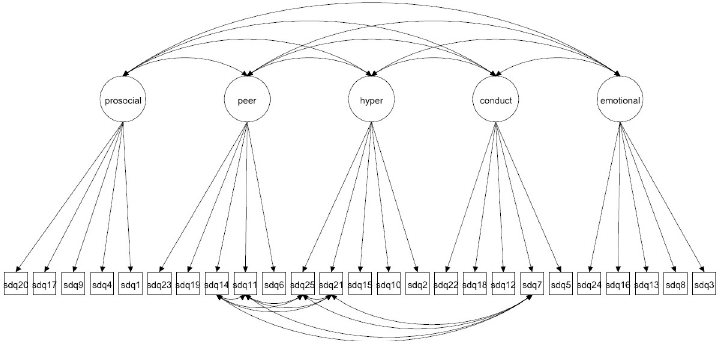
Fig 12. 5-factor model with correlated errors for method effects (Model